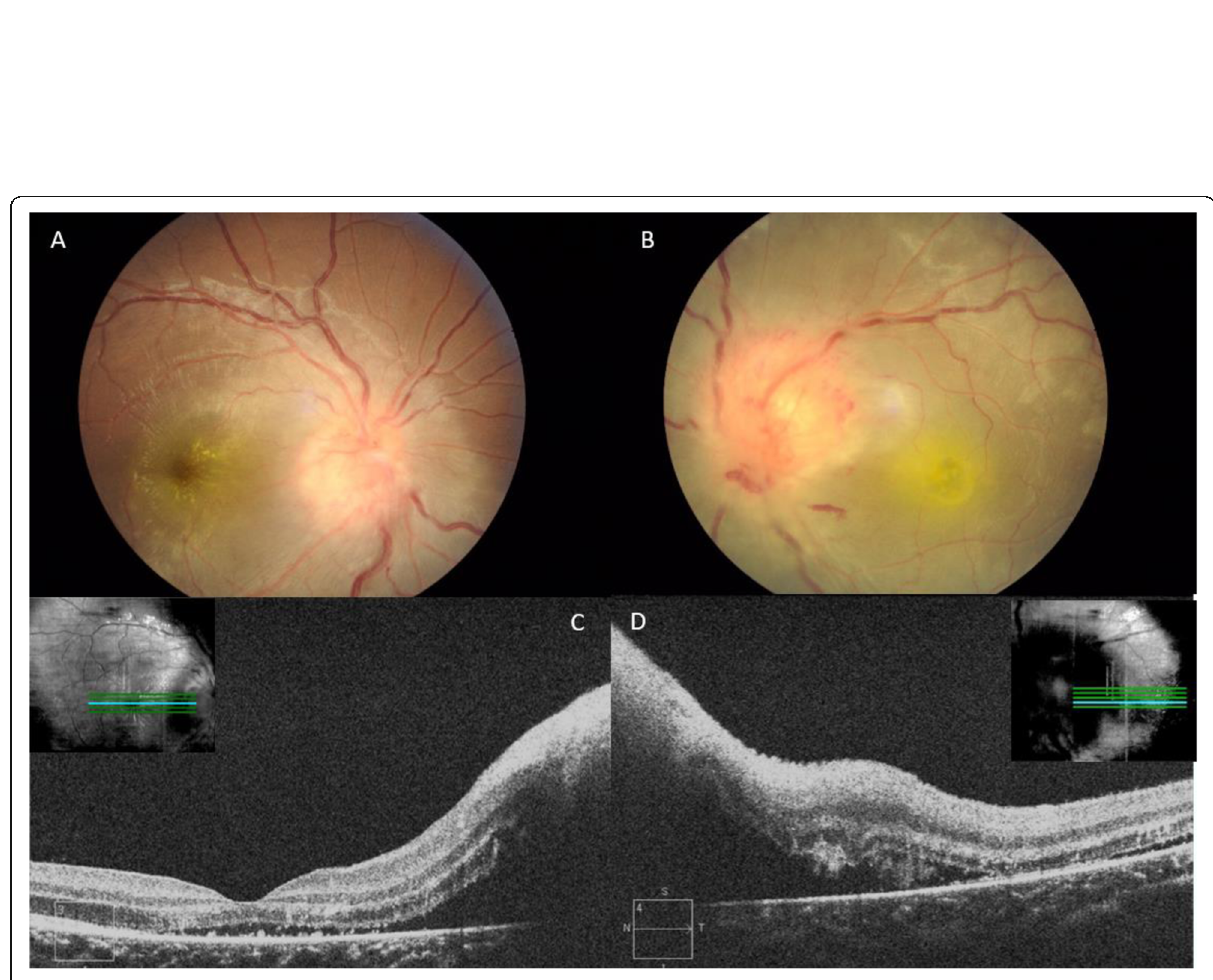
Fig. 4 Patient no 6. a and b Colour fundus photograph of the right and left eye respectively: both eyes have optic disc oedema with yellowish macular exudation (forming bilateral neuroretinitis) and also marked venous engorgement and tortuosity. c and d Corresponding SD-OCT macula of the right eye and left eye: fluid tracking from the oedematous optic disc to the subretinal space. Left eye especially, exhibits a loss of the normal foveal contour and marked serous macular